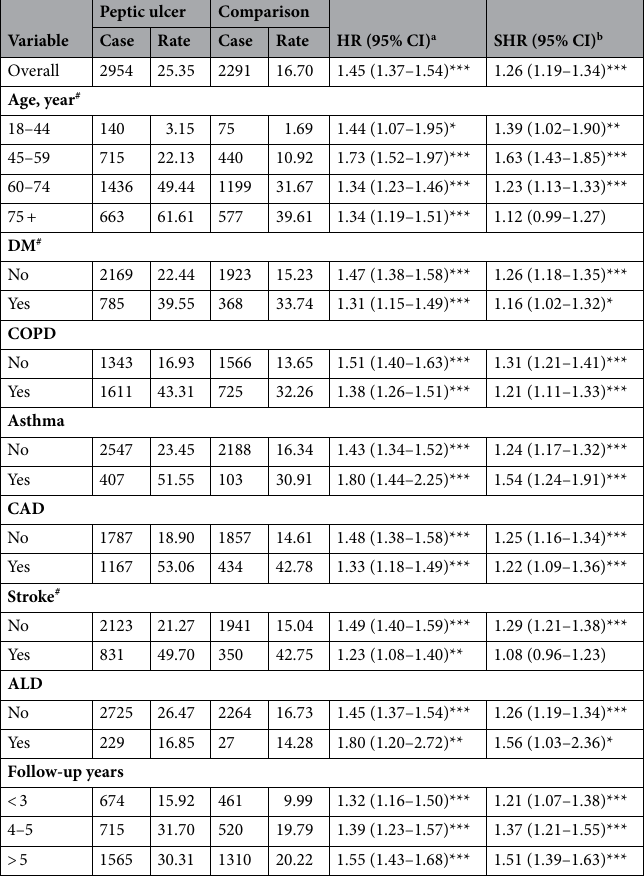
Table 3 showed the association between BPH and peptic ulcer patients underwent surgery. Peptic ulcer patients without surgery showed the highest BPH incidence (25.58 per 1000 person-years), followed by peptic ulcer patients with surgery (23.70 per 1000 person-years), and comparisons (16.70 per 1000 person-years). At the follow-up 16 years, the cumulative incidence of BPH in peptic ulcer patients without surgery and with surgery were higher than comparisons (23.24% and 32.81% vs. 30.25%) (Fig. 2B). When compared to the comparison cohort, the peptic patients without surgery had a higher BPH risk (HR 1.46 and 95% CI 1.38–1.55; SHR 1.26 and 95% CI 1.19–1.34), followed by those with surgery (HR 1.39 and 95% CI 1.24–1.57; SHR 1.24 and 95% CI 1.10–1.40) (Table 3). Among different peptic ulcer associated-surgery, patients with simple suture had a significant higher BPH risk when compared to comparisons (HR 1.50 and 95% CI 1.33–1.70; SHR 1.33 and 95% CI 1.17–1.51). How- ever, patients underwent TVP and other surgery were with a lower incidence of BPH, but without significance.